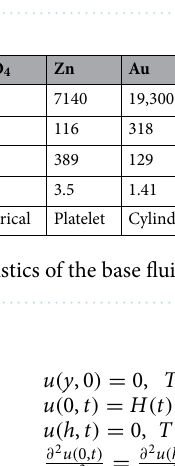
Figure2. The preparation method for ternary hybrid nanofluid.